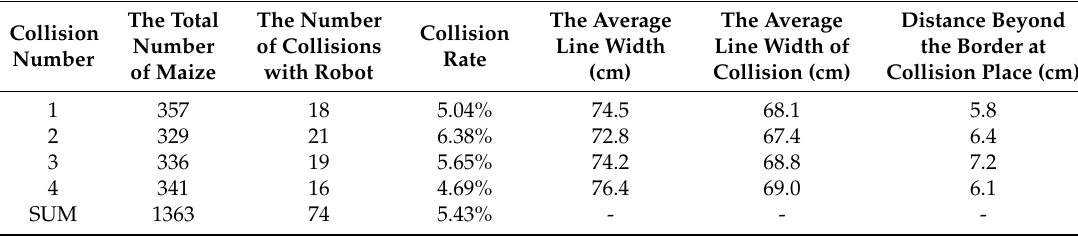
Table 3. The results of collision rate